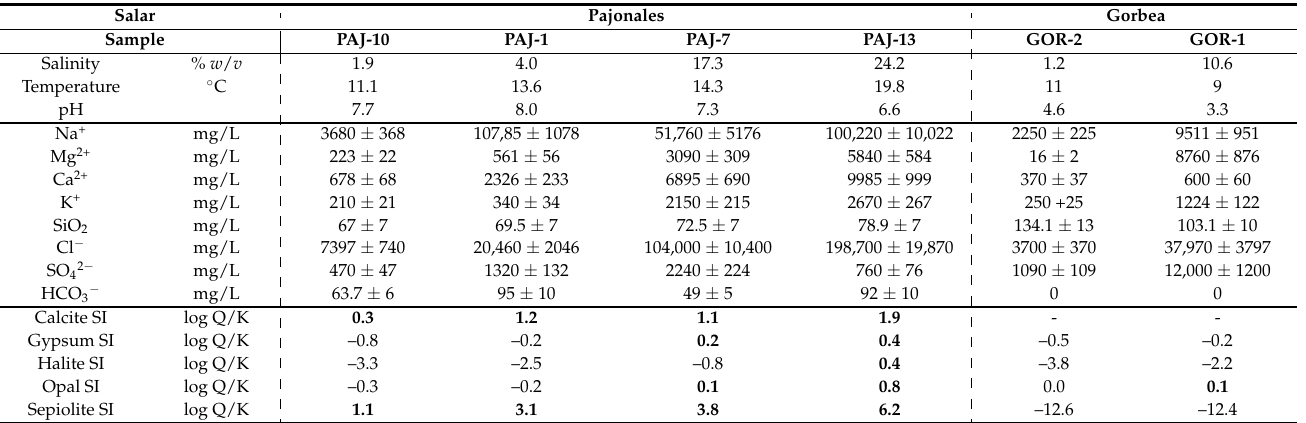
Table 1. Physicochemistry, hydrochemistry, and geochemical modeling of representative brines from Salar de Pajonales and Salar de Gorbea. Pitzer equations were used for saturation indices (SI). Supersaturated values in